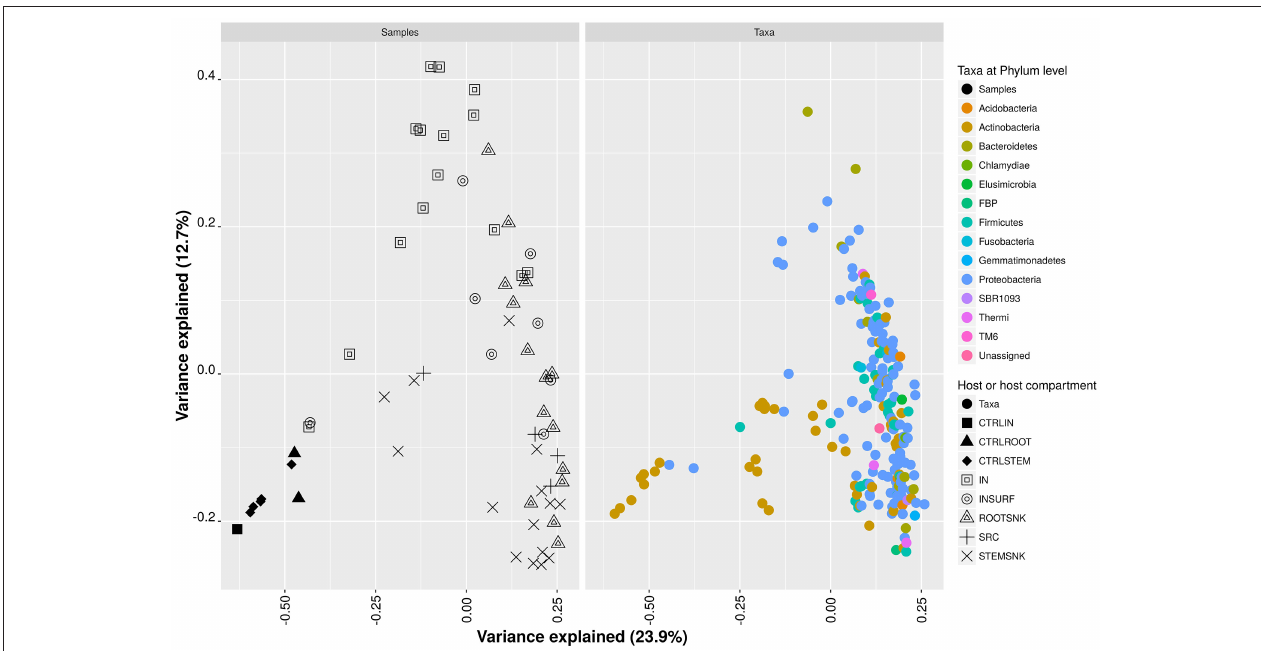
FIGURE 5 | Principal coordinate analysis of a rarefied OTU table at phylum level. Dissimilarities were calculated using the Bray-Curtis distance estimator. Variance per axis is presented as